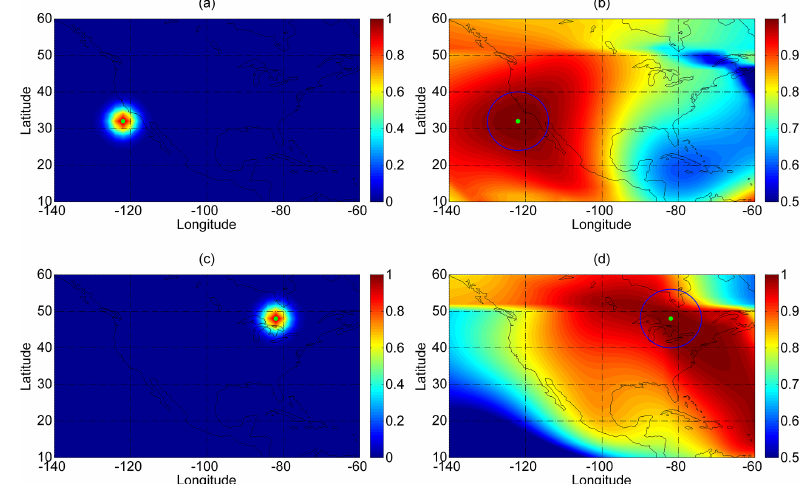
Figure 2. The horizontal correlation at 00:00UTC. (a) The location-independent horizontal correlation modeled using a Gaussian function at altitude 200km with respect to a grid point at long − 122 ◦ and lat 32 ◦ marked by the green dot. (b) The location-dependent horizontal correlation modeled with the horizontal EOF profiles and its EOF coefficients’ covariance for the same reference point as (a) . The blue circle surrounding the dot is the full length of the Gaspari and Cohn localization function, with which the correlation is tapered towards zero from the center (green dot) to the rim of the blue circle. (c) The location-independent horizontal correlation at altitude 200km with respect to a point at long − 82 ◦ and lat 48 ◦ . (d) The location-dependent horizontal correlation for the same reference point as (c)